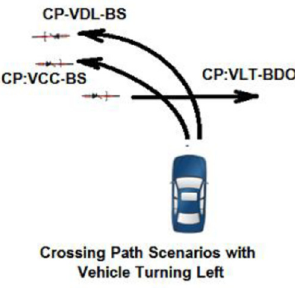
Figure 8 Crash geometry of CP:VLT scenarios